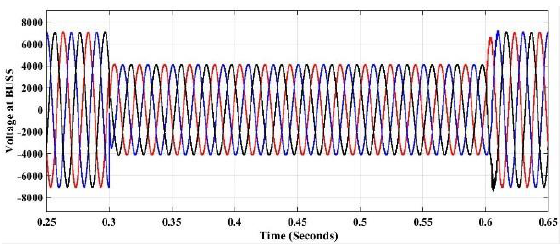
Fig12 IEEE 5 Bus System in MATLAB/Simulink Fig.17 Voltage sag detected at BUS5 DVR is connected between BUS 4 and BUS 5. The DVR injects the difference of 2.96kV voltage into the system using Injection transformer. The Voltage at BUS5 after injection of Voltage into the system is shown in Fig.18. Table 4 DVR Parameters for case study 4